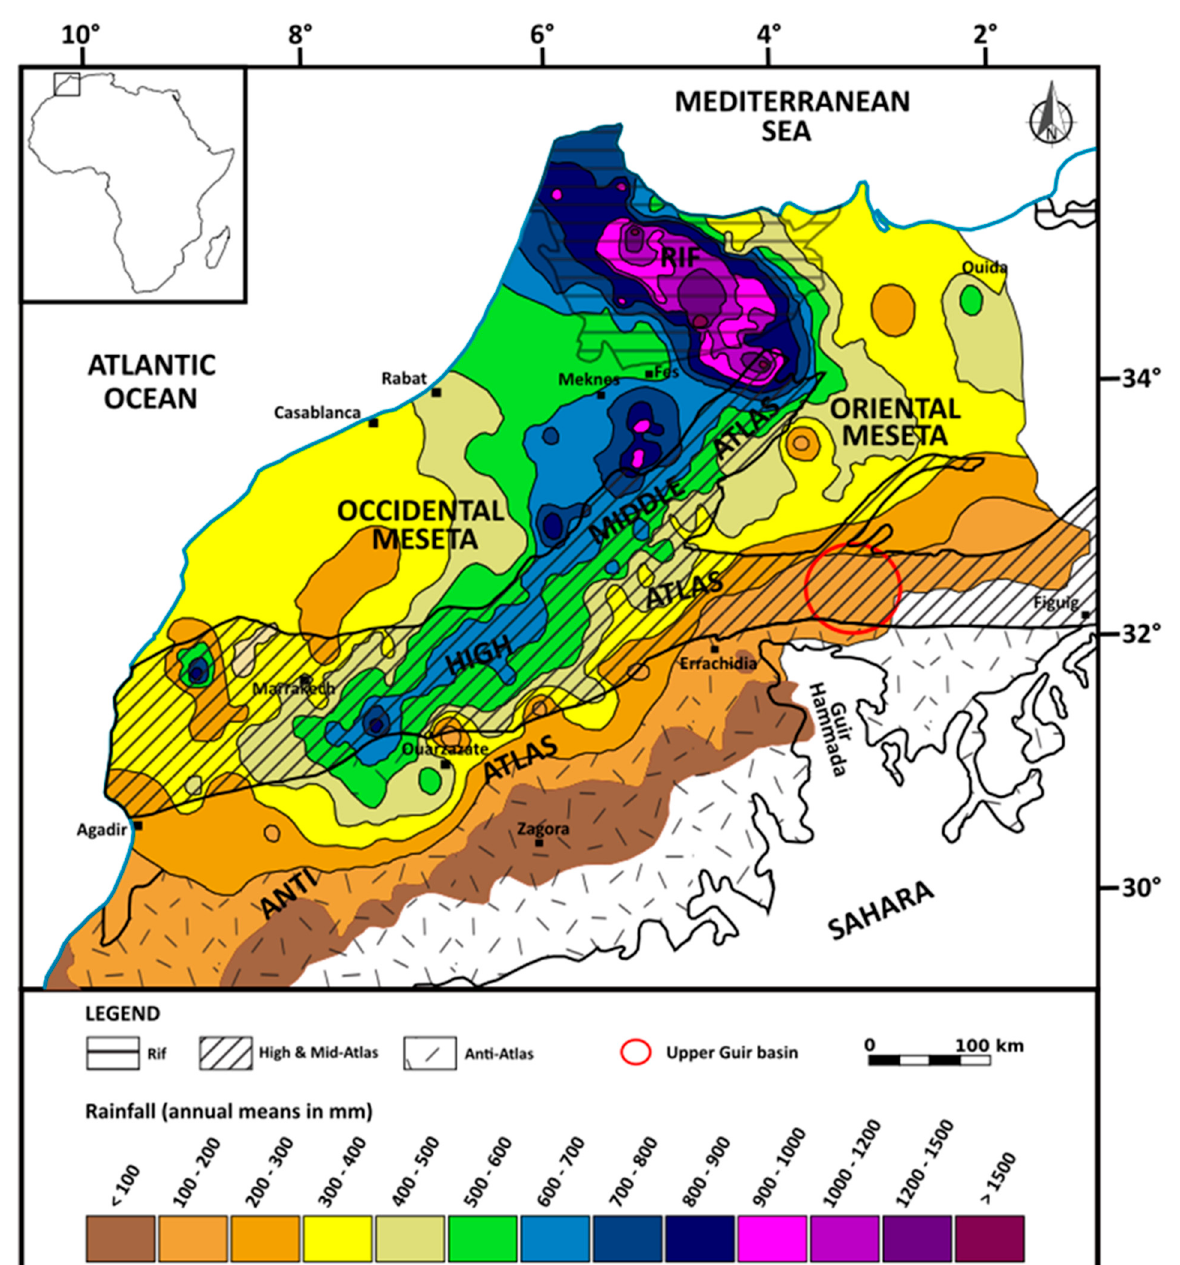
Figure 7. Synthetic map of the average annual rainfall in relation to general topography and especially with great structural units of Atlas and Rif (modified from [25,26]).